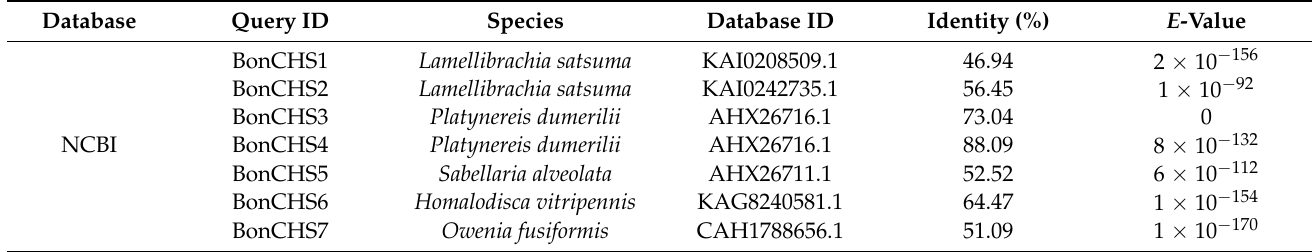
Table 4. The top-hit BLAST results against NCBI and UniProt